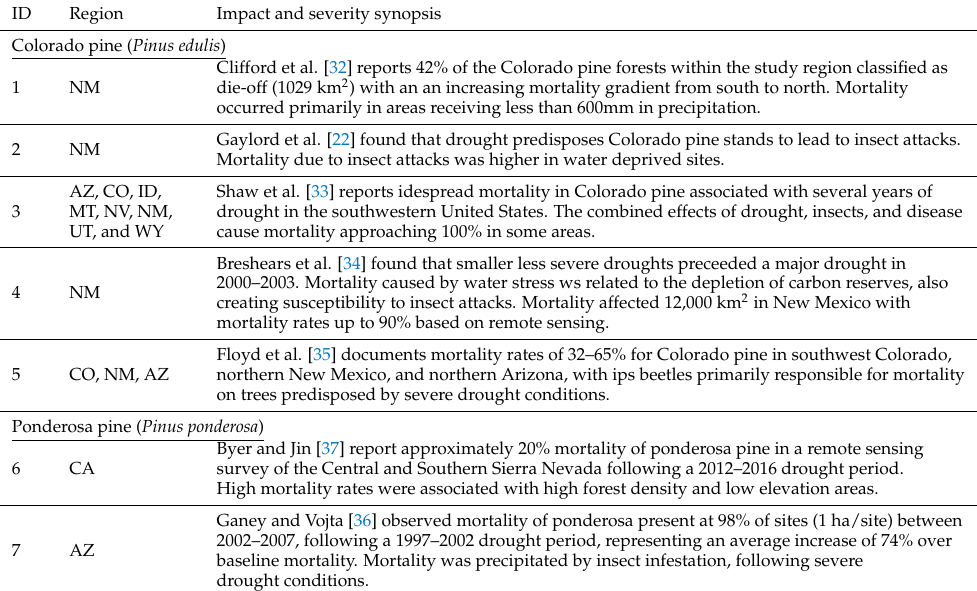
Table A1. References and brief synopsis of observed dieback and mortality of three western North American tree populations. The ID field corresponds to locations shown in Figure 3.